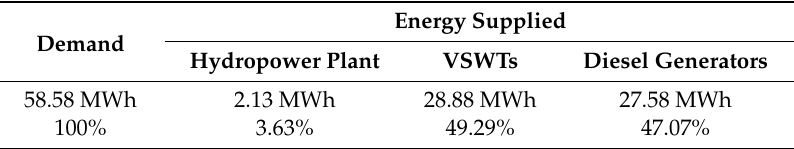
Table 1. Energy supplied by each generation technology during 2016 [25].